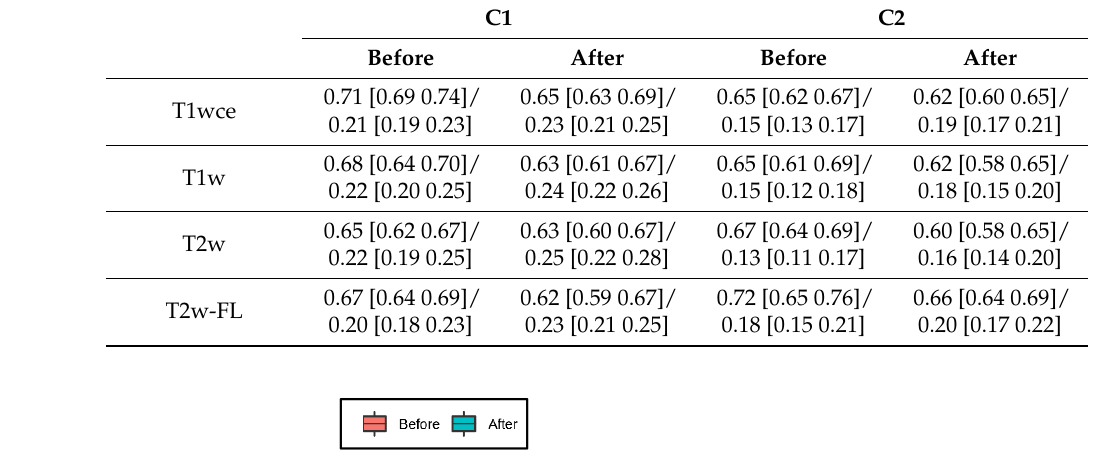
Table 3. Performance of the top-ranked image normalization method separate before and after the elimination of the intensity normalization impacted significant features for cohort C1 and C2 for each MR sequence. The average (across all bin counts) 10-CV C-I/MSE with 95% confidence intervals are reported. Before After Before After